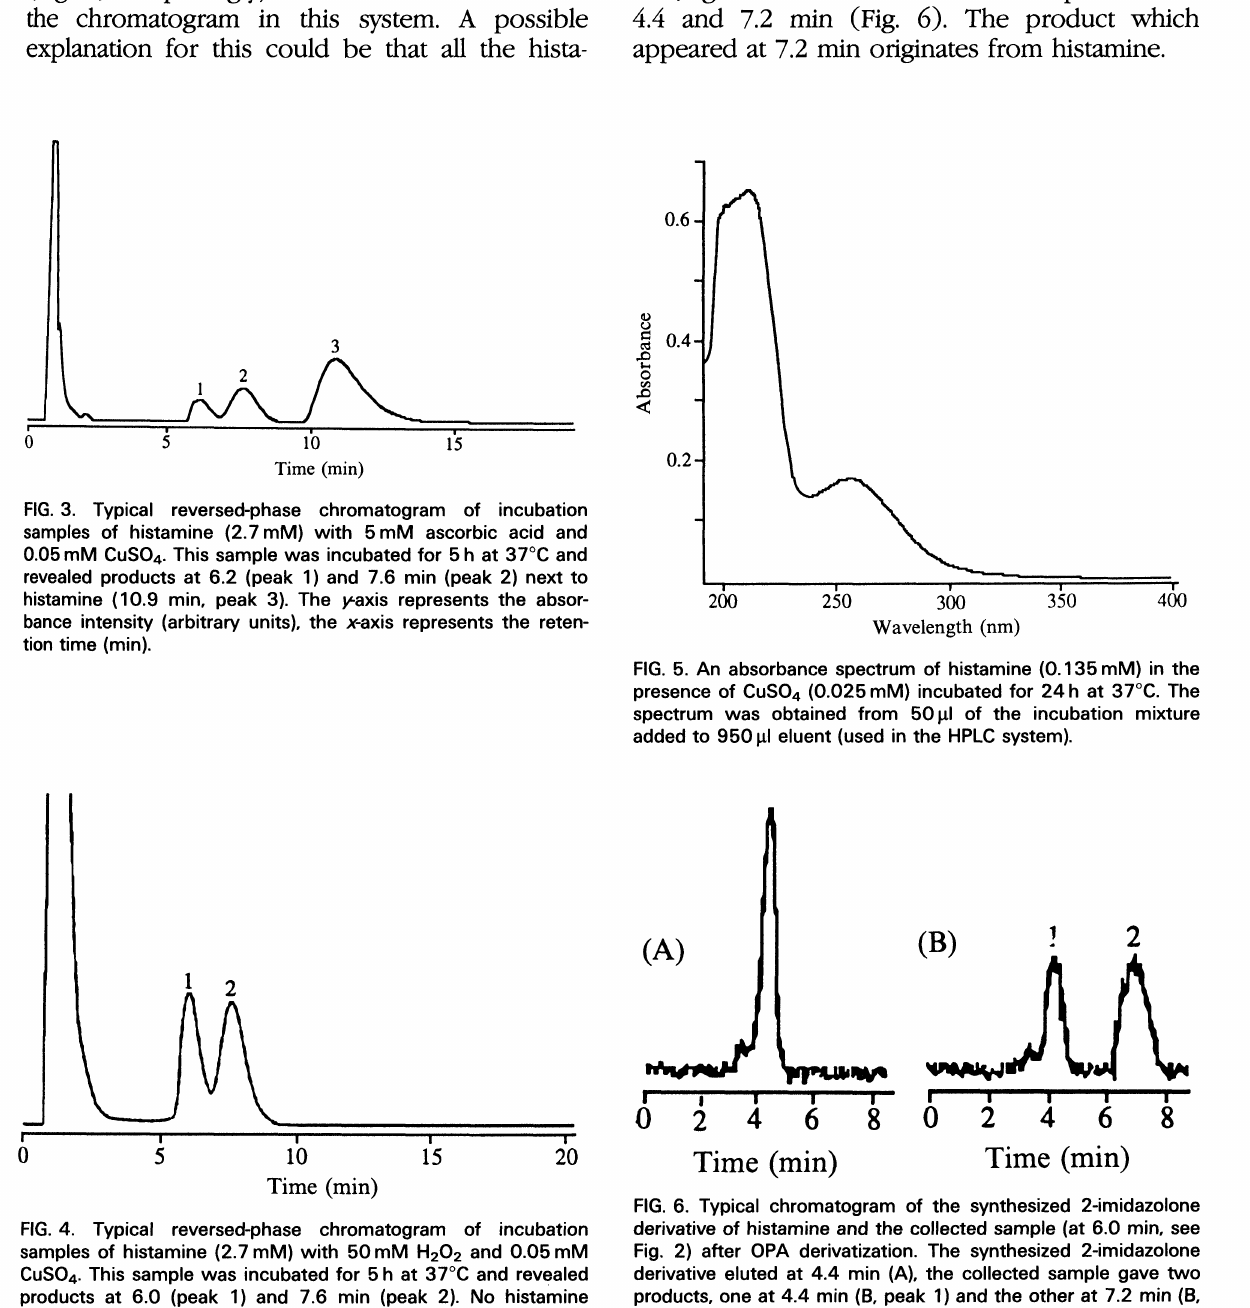
FIG. 4. Typical reversed-phase chromatogram of incubation samples of histamine (2.7mM) with 50mM H202 and O.05mM CuSO4. This sample was incubated for 5 h at 37C and revealed products at 6.0 (peak 1) and 7.6 min (peak 2). No histamine peak was observed. The y=axis represents the absorbance inten- sity (arbitrary units), the x-axis represents the retention time (min).